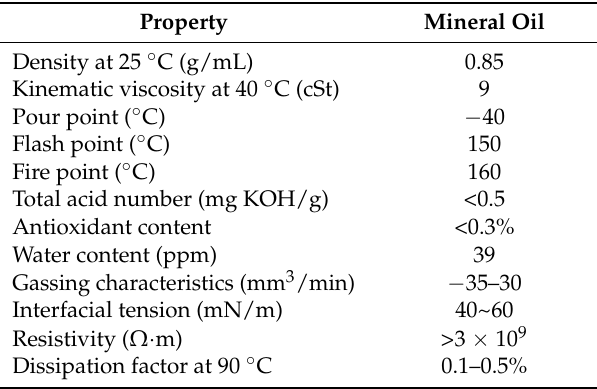
Table 1. Physicochemical properties of mineral oil.